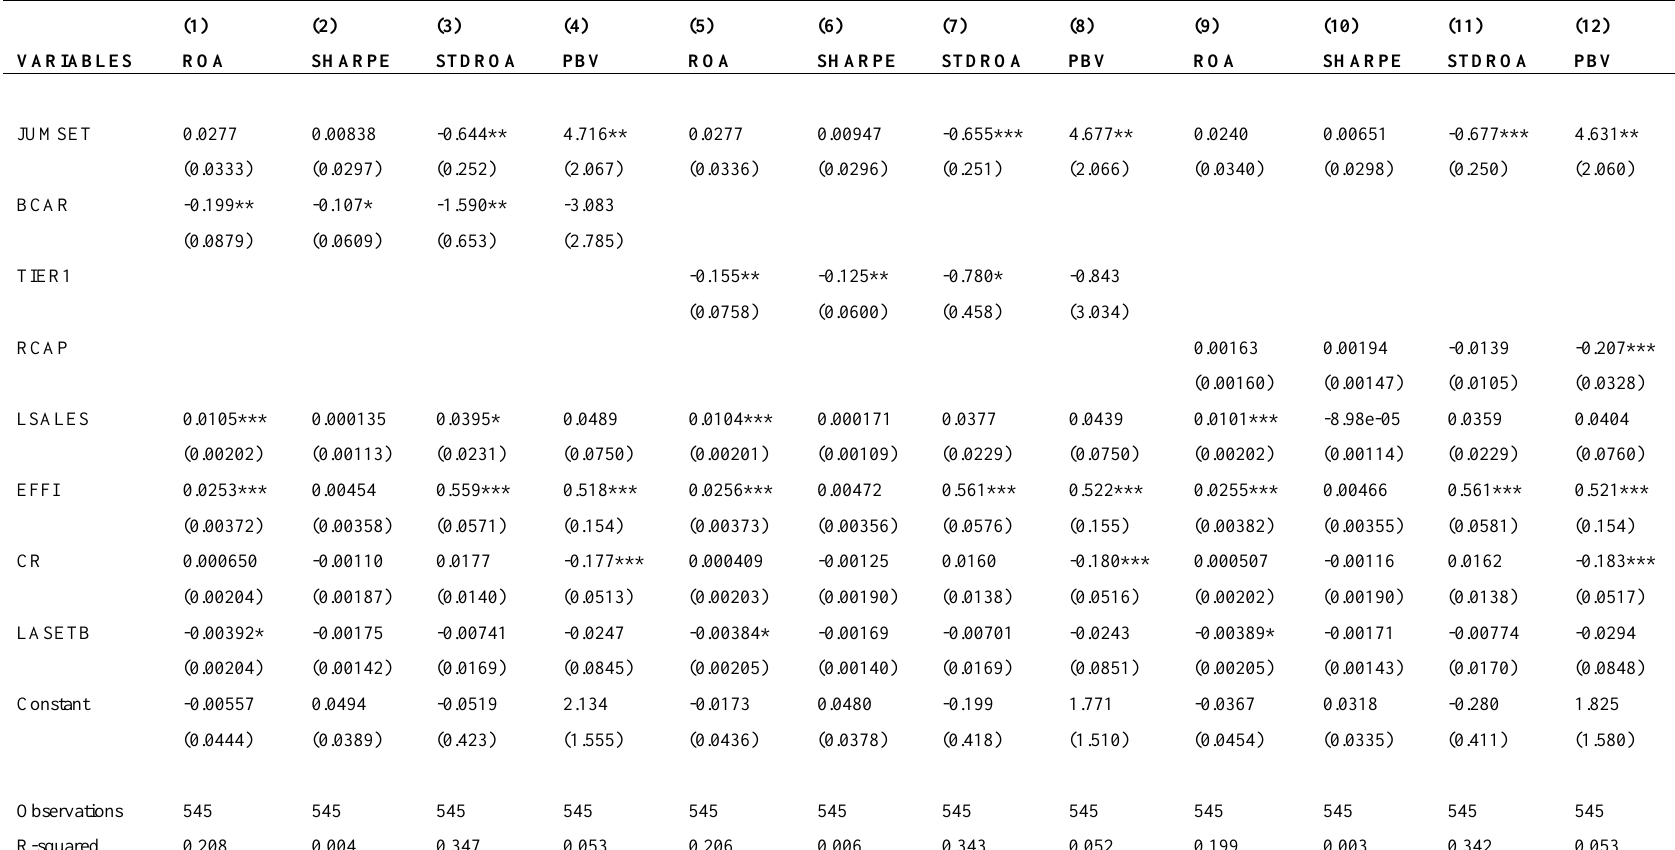
Table 4: Regression results with banks’ capital as independent